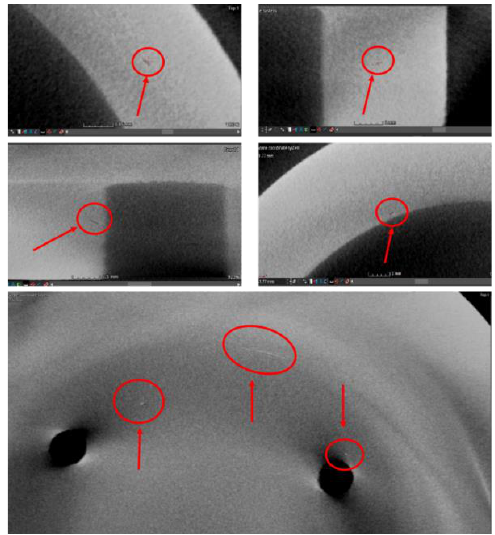
Figure 7. Representative X-ray CT scans for one closed impeller built at B + 60° orientation.